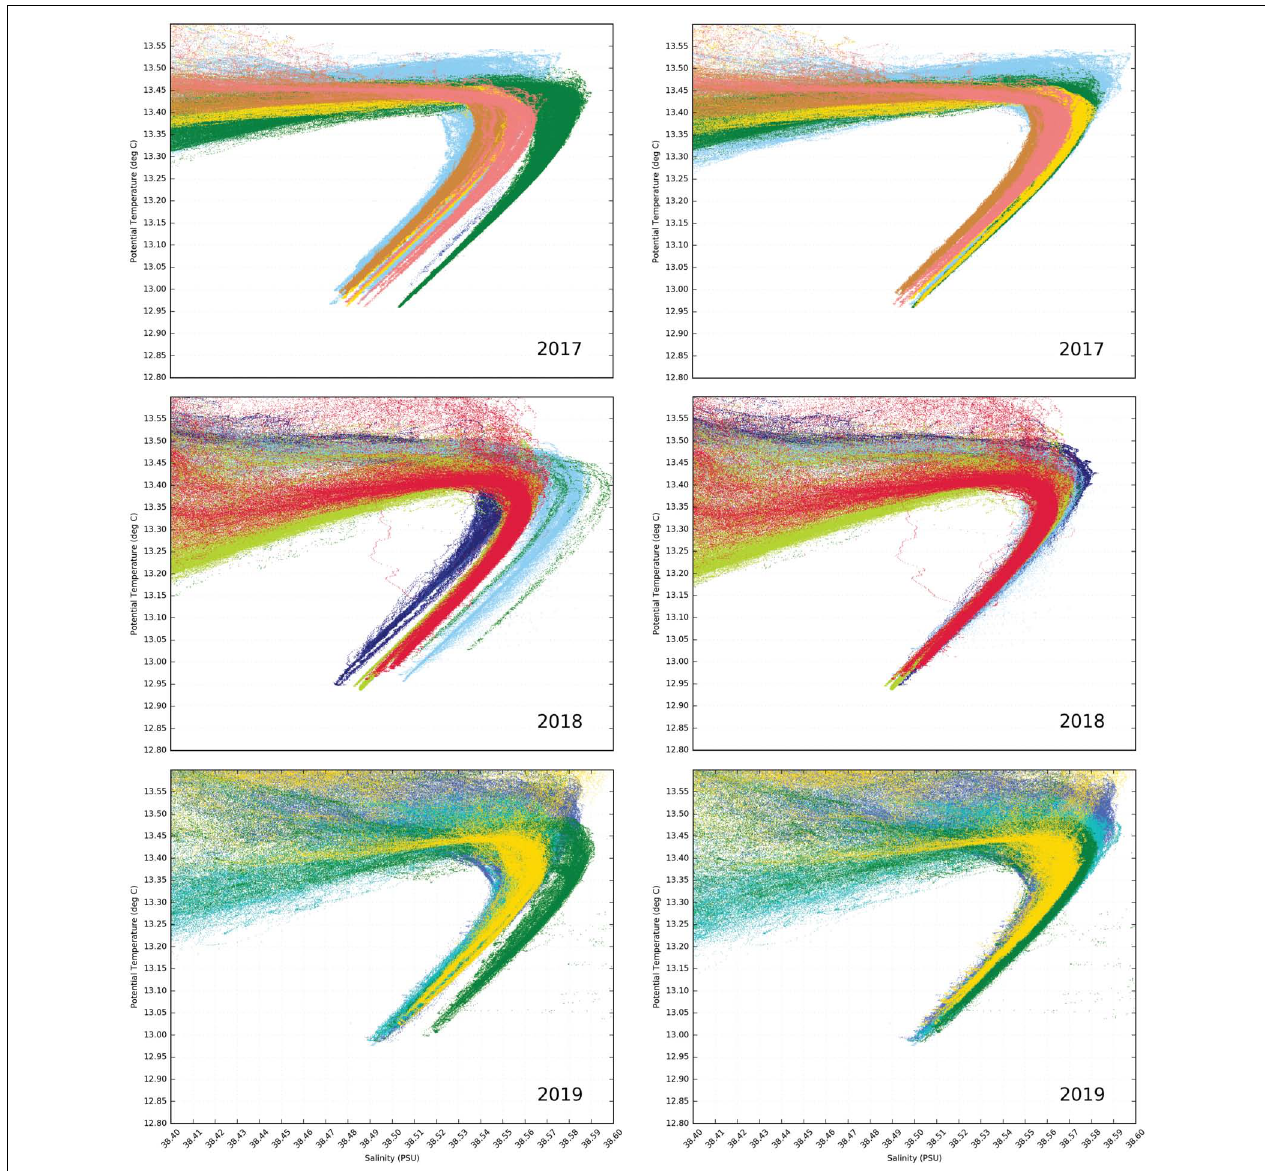
FIGURE 4 | θ /S diagrams zoomed in to show the relatively stable intermediate water mixing line between Levantine Intermediate Water and Western Mediterranean Deep Water for SOCIB glider missions across the Ibiza and Mallorca Channels separated into years from September 2013 to July 2019. On the left are the uncorrected glider profiles, and on the right are the DM field corrected glider profiles ( x -axis tick mark interval is 0.010). These data and the relevant CTD datasets are available through the SOCIB Data Centre website (www.socib.es/?seccion=dataCenter).